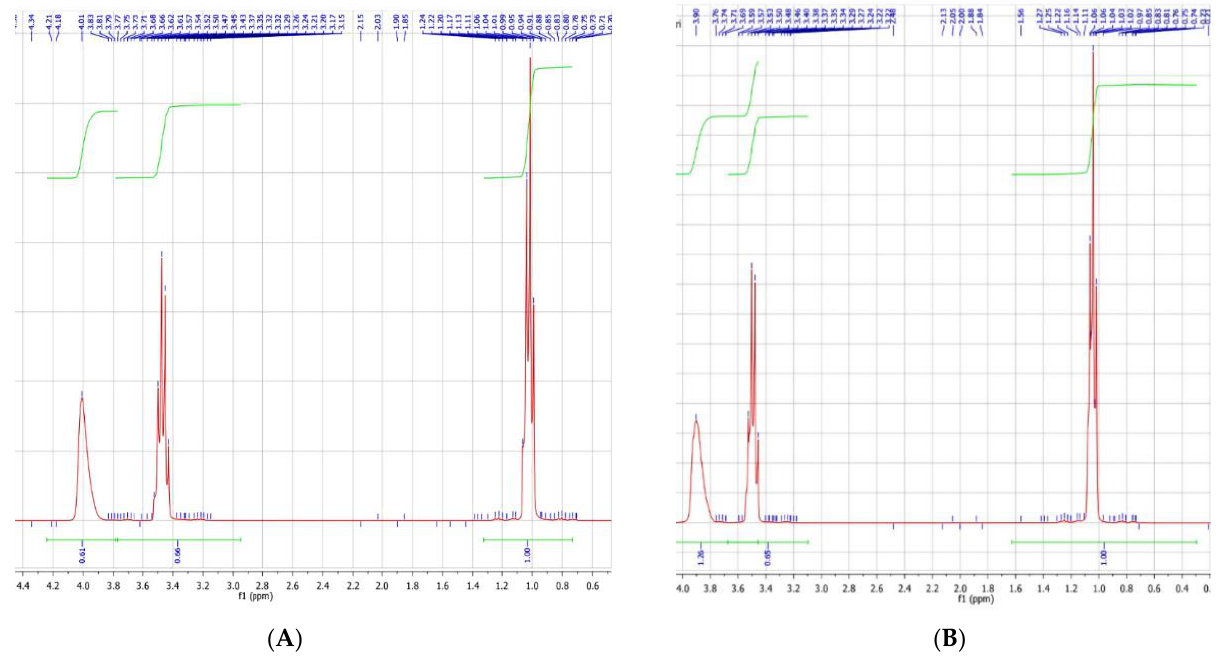
Figure 8. 1H NMR spectra of the optimally produced bioethanol: ( A ) 1 g/L NH 4 Cl and ( B ) 0.4 g/L CaCl 2 .